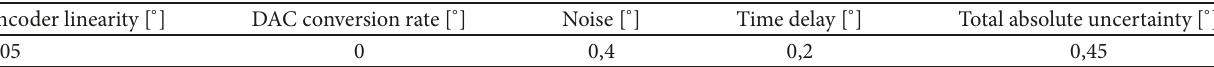
Table 3: Uncertainty budget of position